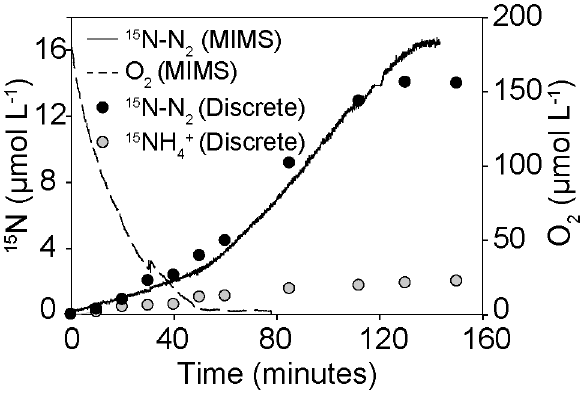
Figure 1. Comparison of incubation methods. Incubations were carried out using either membrane inlet mass spectrometry (MIMS) which allowed for continuous online measurements or by discrete porewater sampling into exetainers and subsequent measurement on a GC-IRMS. The example shown is taken from a replicate during the spring incubations directly after the addition of 15 NO 3 2 .